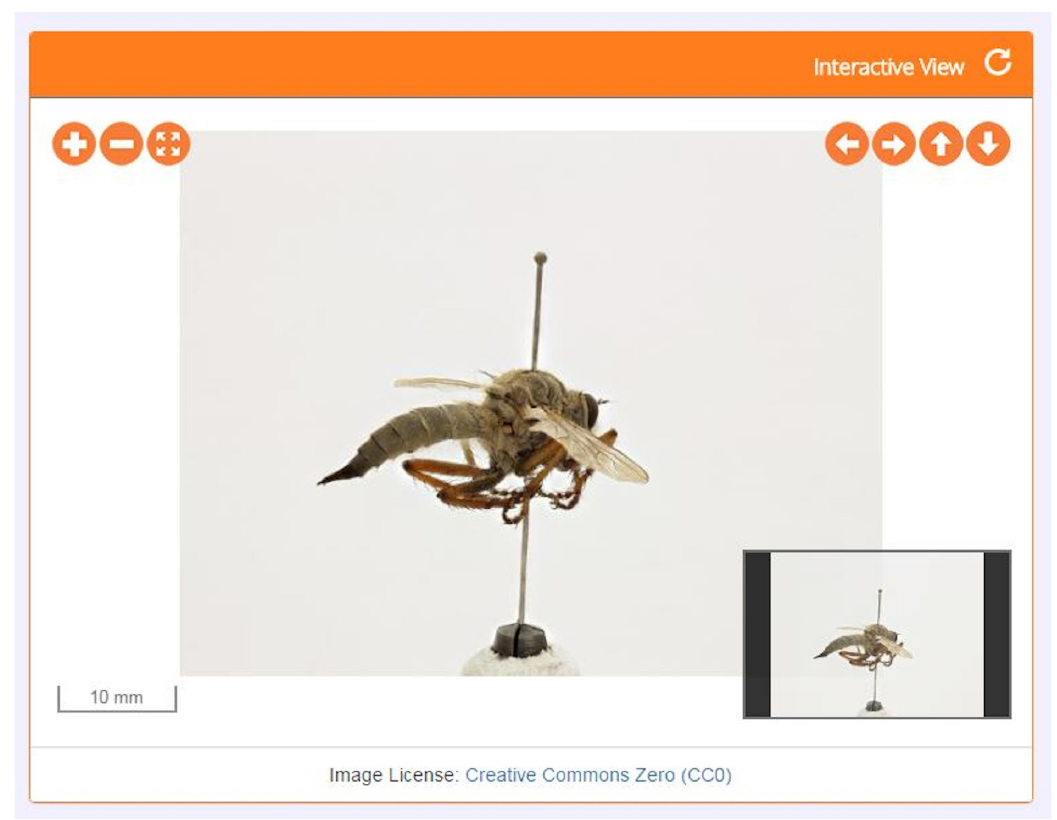
Fig. 2.23. Plane 2 of the specimen page at Zoosphere.net, showing the specimen pictures. Image copyright MfN.